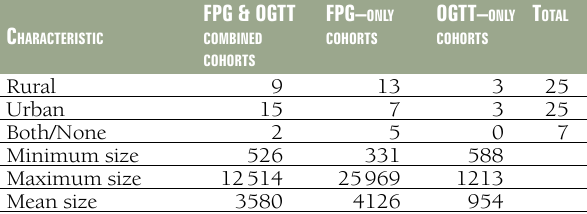
Table 7. General cohort characteristics C haraCteriStiC